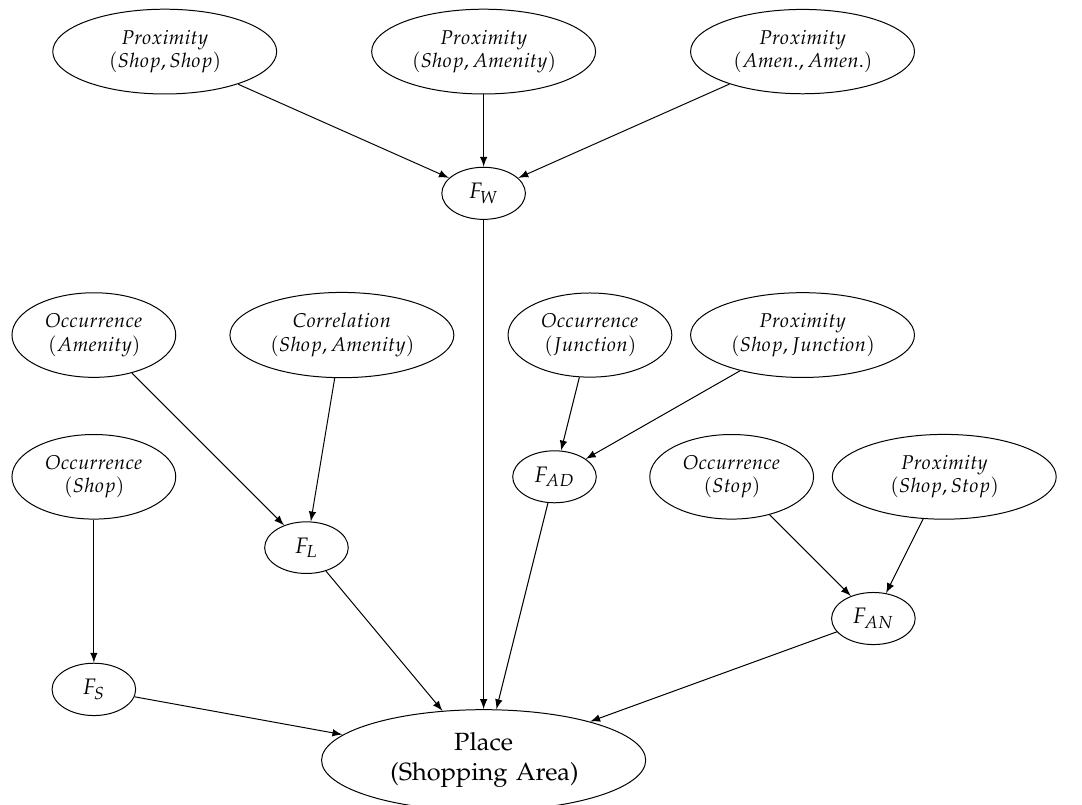
Figure 3. Bayesian network for a place functioning as a shopping area.